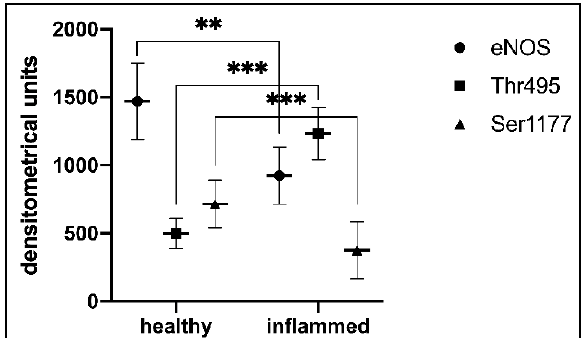
Figure 5. The staining intensities of t-eNOS, Ser1177, and Thr495 in blood vessels of the healthy and inflamed human dental pulp. In both healthy and inflamed pulp blood vessels, eNOS is detected. However, the staining intensity for eNOS in healthy blood vessels is more intense than in inflamed blood vessels. The staining intensity of Ser1177 in healthy blood vessels is significantly higher than in inflamed blood vessels, whereas the weak staining intensity of Thr495 in healthy blood vessels shows a significant increase in inflamed blood vessels. Asterisks indicate significant differences between two compared groups (** p < 0.005; *** p < 0.0005). For each group, n = 8; data are mean ± SD; significant differences were considered at a p value <0.05.